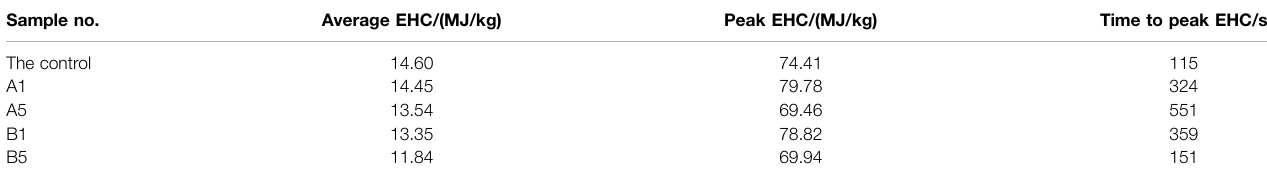
TABLE 4 | EHC of bamboo specimens before and after LbL self-assembly with PA-PEI in initial 360 s. Sample no.